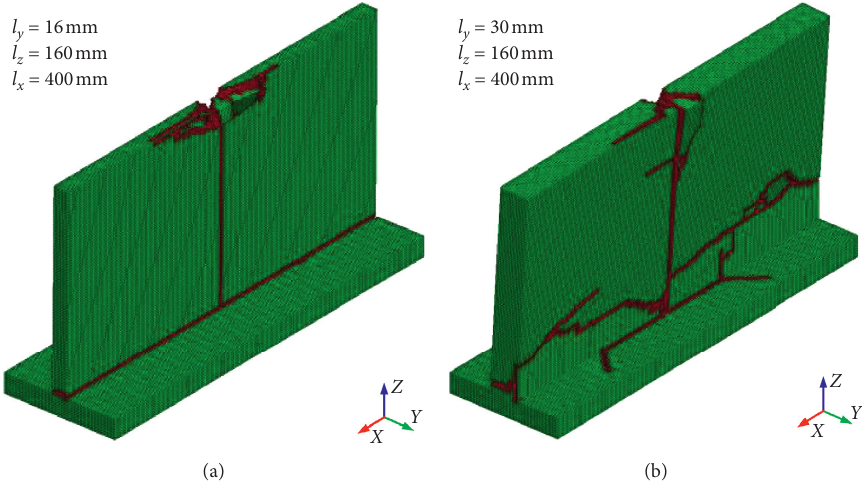
Figure 14: Cutting results of rock plate with different thicknesses: (a) 16mm and (b) 30mm.